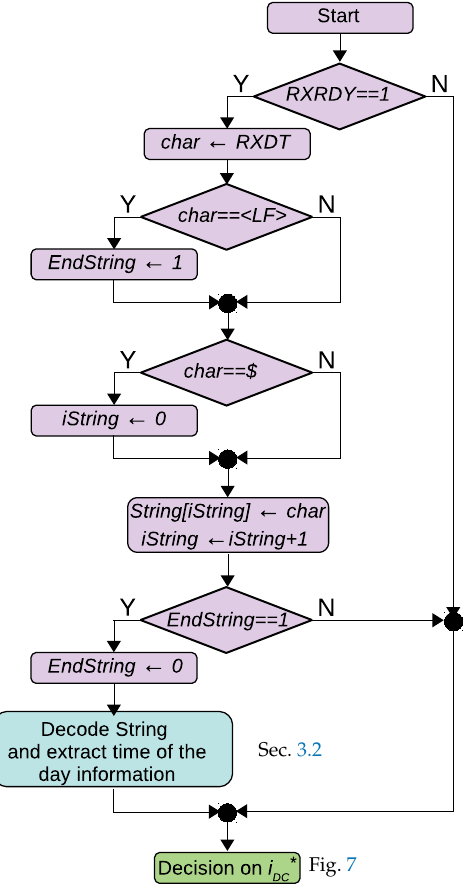
Figure 9. Algorithm for reception of NMEA command on the TMS320F28335